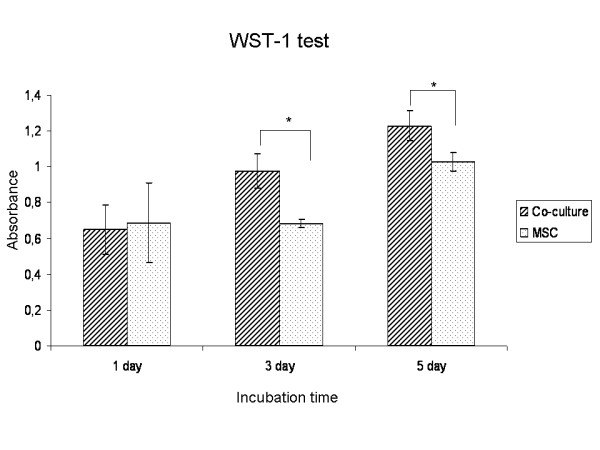
Results obtained by WST-1 assay to describe cell viability and proliferation after 1, 3 and 5 days. The data were representative for all donors and presented as mean ± standard deviations. * P < 0.05 (compared with MSC group).